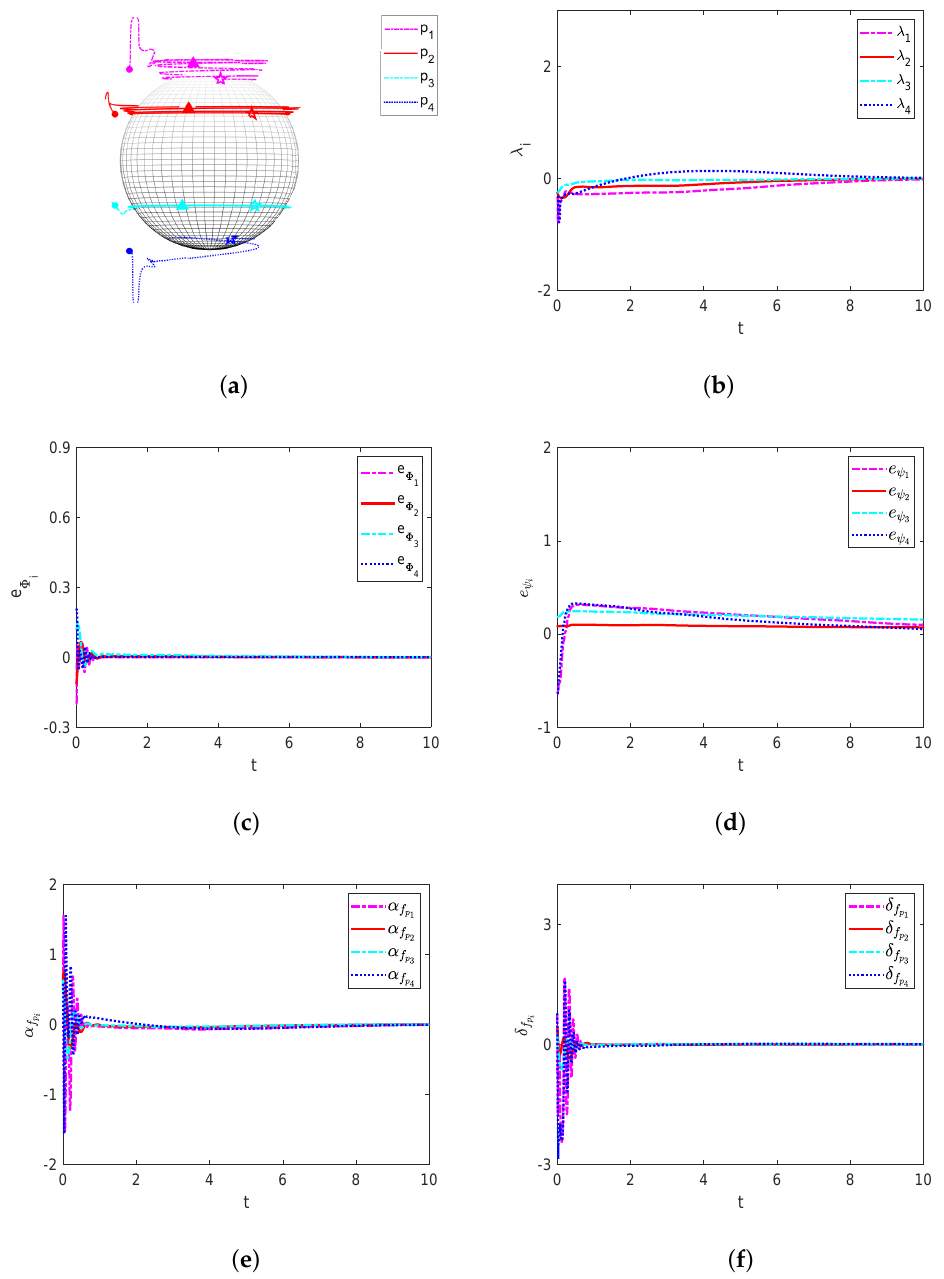
Figure 2. Spherical formation tracking motion with time delays: ( a ) spherical motion trajectories; ( b ) plot of λ i ; ( c ) plot of e φ